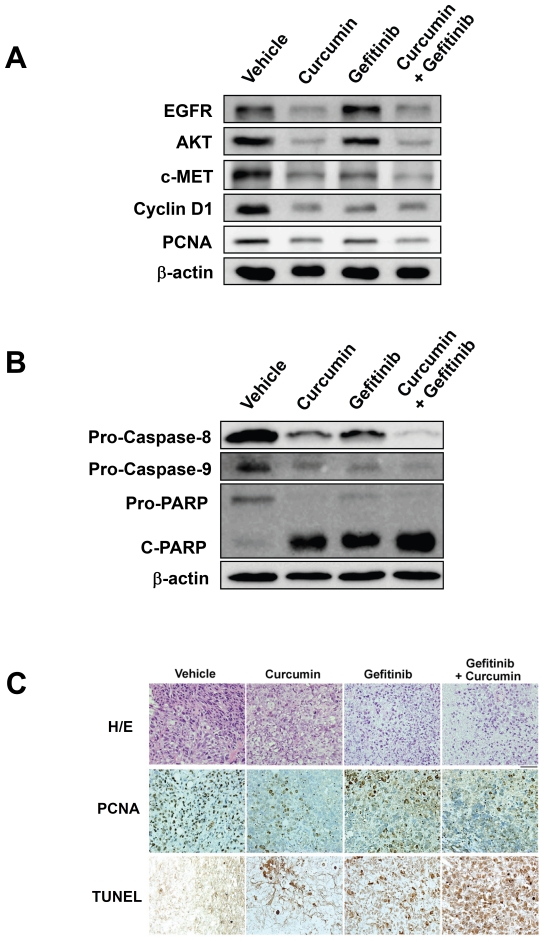
Curcumin enhances the effect of gefitinib against gefitinib-resistant relative proteins and by inducing apoptosis activity CL1-5 xenograft tumors.(A) Western blotting analysis the gefitinib-resistant relative proteins EGFR, AKT, c-MET, cyclin D1, and PCNA showed the expression inhibition in curcumin alone or in combination group of xenograft tumor tissues. Western blotting results are represented with β-actin used as the internal control. Samples were pooled together from three animals in each group were analyzed and representative data are shown. (B) Western blotting analysis showing that combination of curcumin and gefitinib inhibits the expression of pro-caspase-8, pro-caspase-9 and pro-PARP and enhances the level of the cleavage (c)-PARP in xenograft tumor tissues. Western blotting results are represented with β-actin used as the internal control. Samples were pooled together from three animals in each group were analyzed and representative data are shown. (C) H&E staining, immunohistochemical staining of proliferation marker PCNA and apoptosis detection of TUNEL analysis in xenograft tumor sections from each group indicating that curcumin inhibited the tumor cell proliferation and enhanced the apoptotic cell death of gefitinib under a light microscope (×400 magnification).